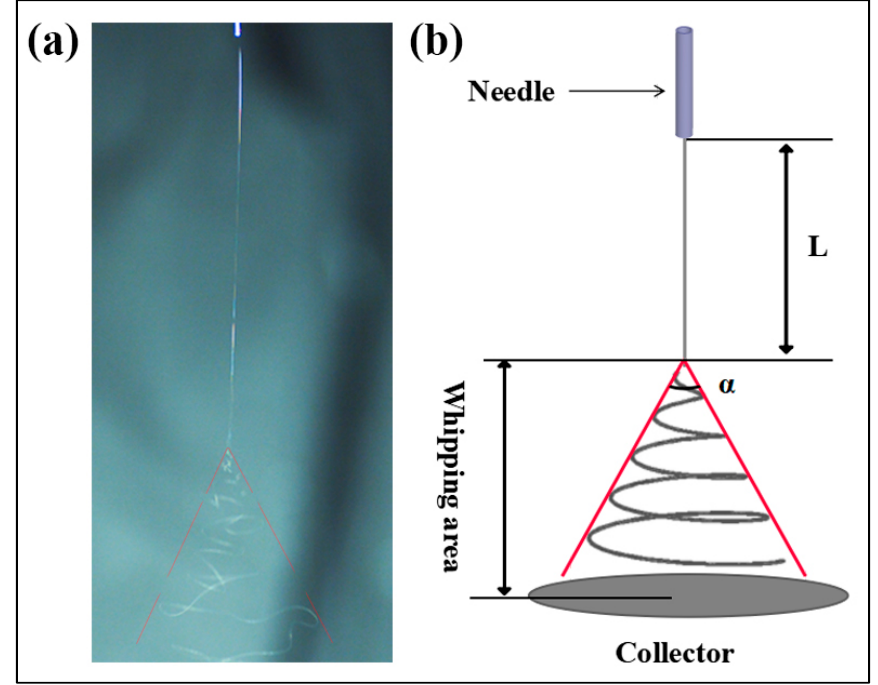
Figure 3. ( a ) A high-speed photograph of jet motion at 6400 fps and ( b ) jet path schematics of the electrospinning process.